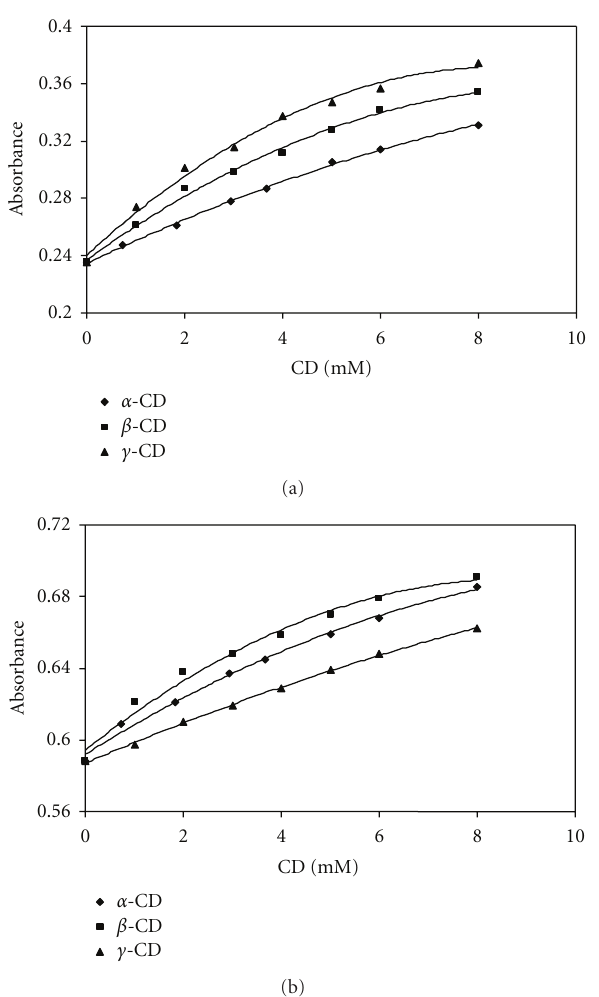
Figure 4: (a) The absorbance change of 4 . 0 × 10 − 5 M TMP with the concentrations of CDs. (b) The absorbance change of 4 . 0 × 10 − 5 M SMX with the concentrations of CDs.